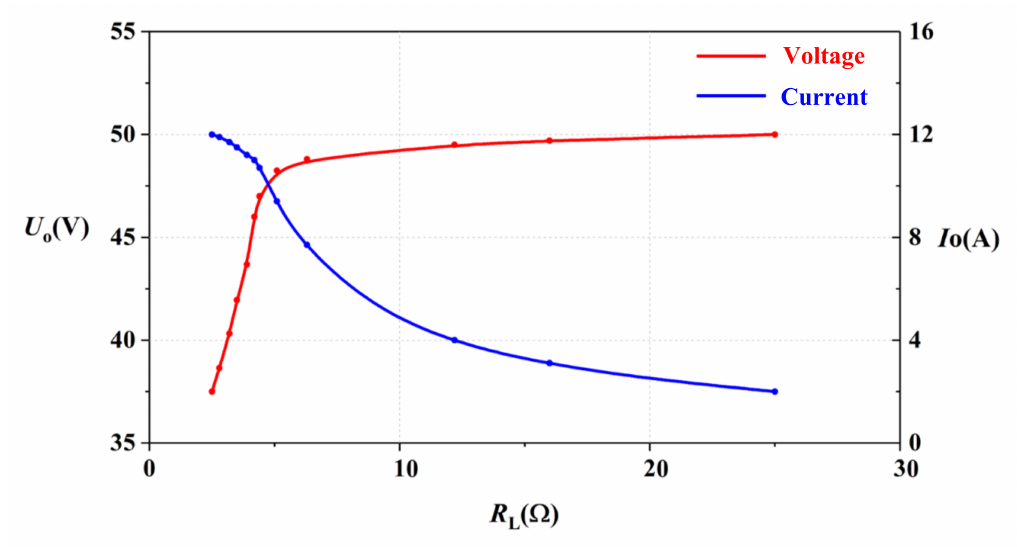
Figure 16. Variation of load voltage and current with load resistance.